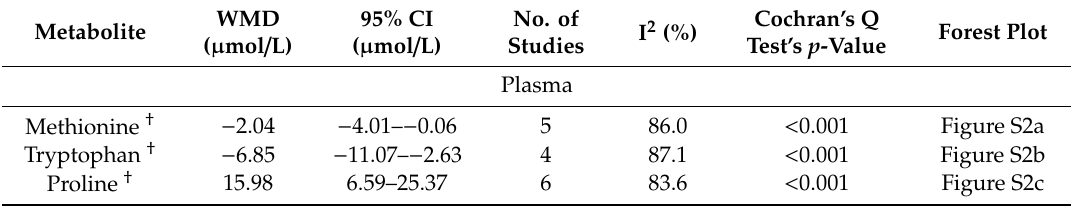
Table 4. Weighted mean di ff erence (WMD) and 95% confidence interval (CI) of the of the plasma metabolite concentration between lung cancer patients and healthy controls, for metabolites that achieved statistical significance. Refer to Figure S2 for the forest plot of each